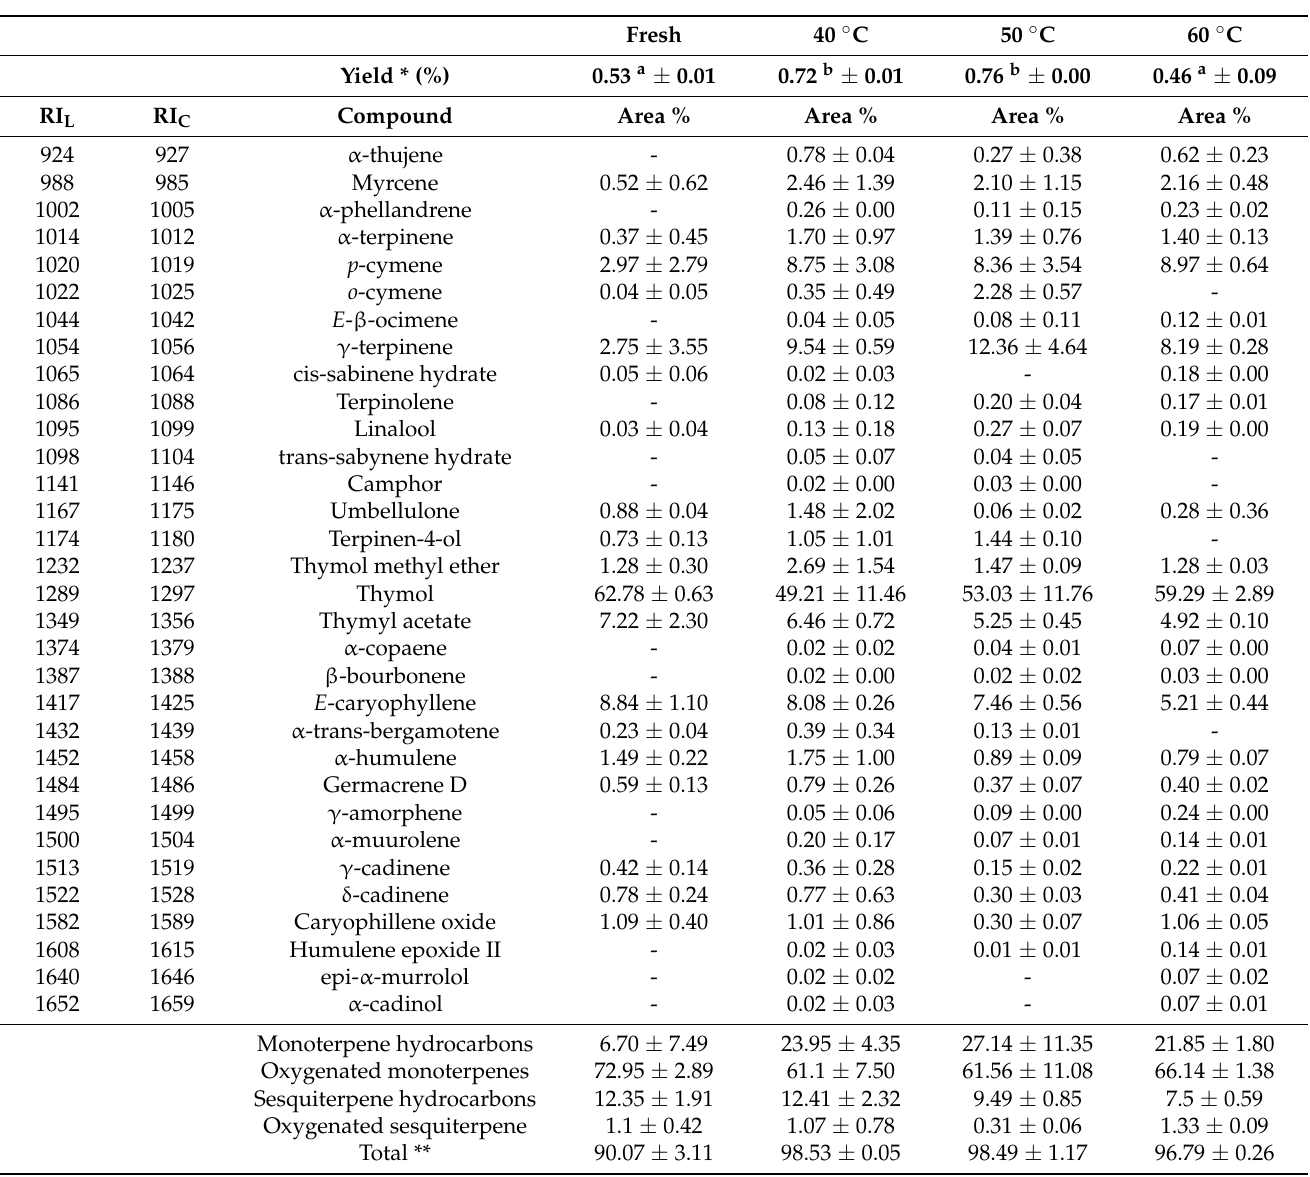
Table 2. Yield, chemical constituents and their percentage variation in the essential oils of Lippia thymoides leaves after the drying process at 40, 50, and 60 ◦